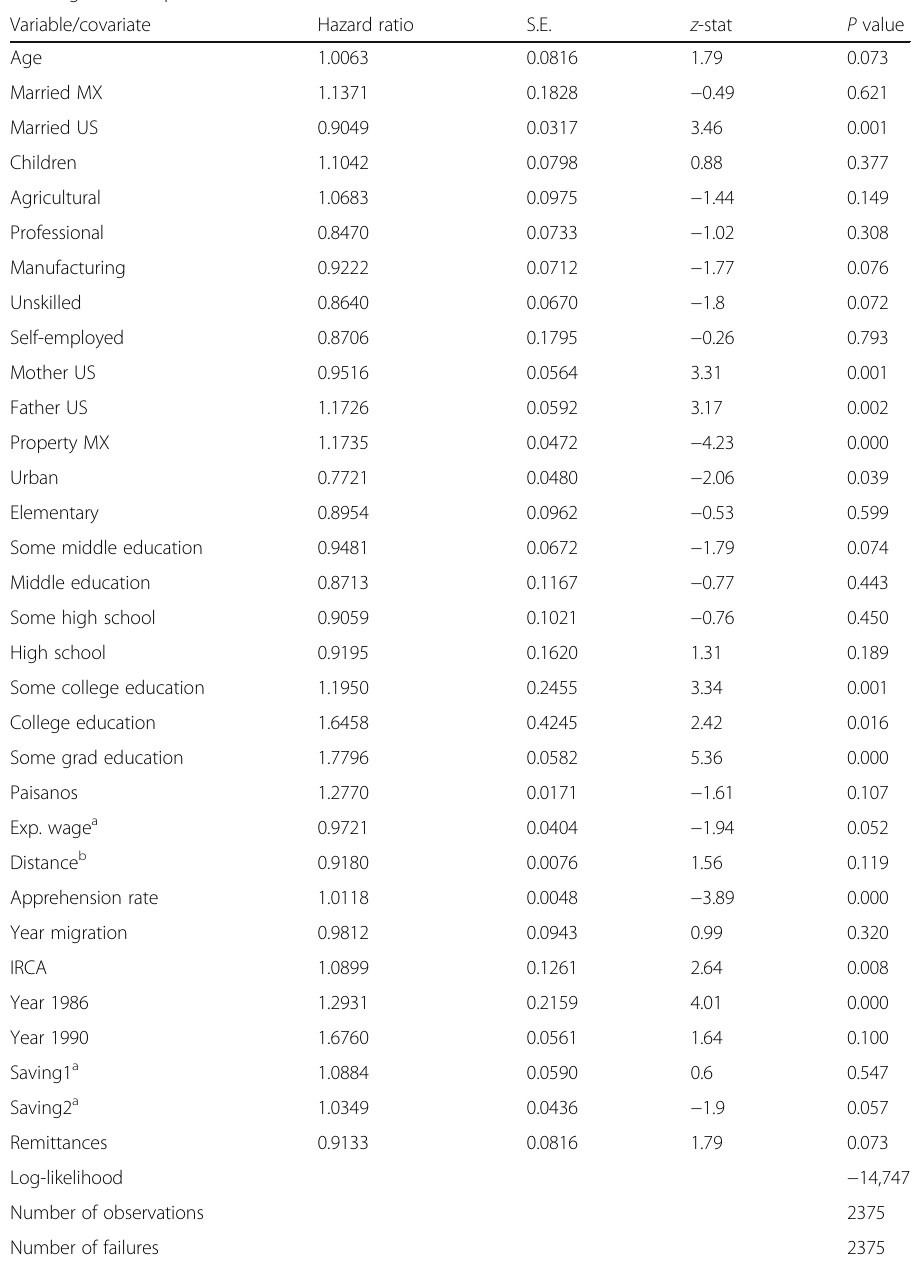
Table 5 Estimates of the determinants of the hazard of returning to Mexico for the first migration